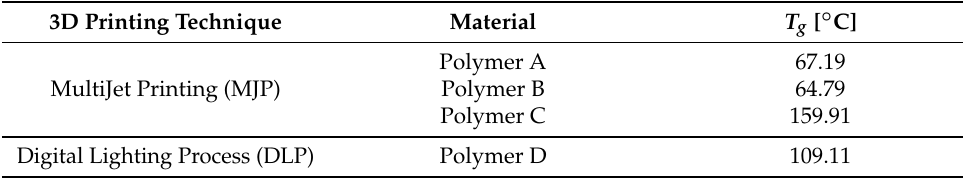
Table 2. Glass transition temperature ( T g ) for 3D-printed polymers.